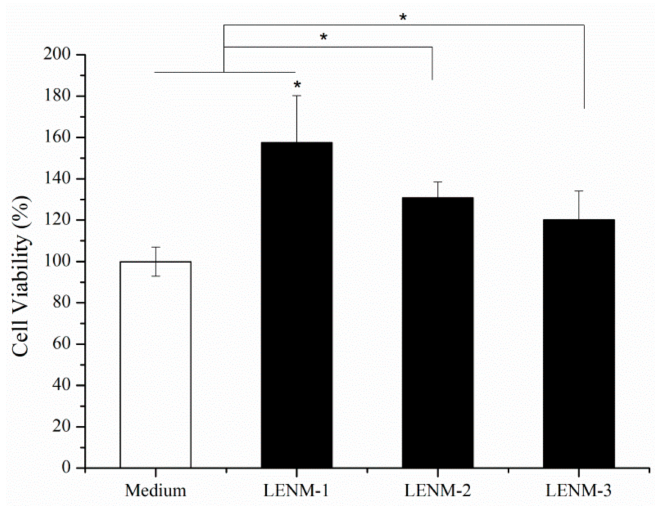
Figure 5. The cell viability of LENMs. * p < 0.05 compared with the control